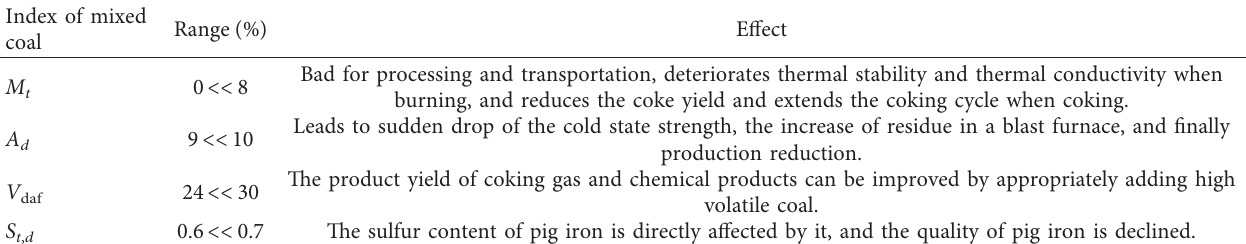
Figure 1: Coke production. Table 1: The range of content of mixed coal corresponding indicators and the impact on coke